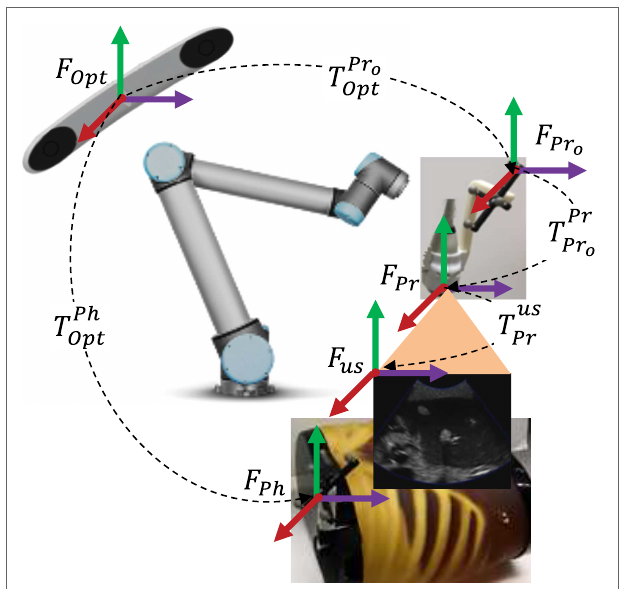
FIGURE 8 | Experimental setup transformation map . During the experiments, the camera frame, F Opt , and the transformations T Pr Pro and T us Pr remained fixed, and the transformations T Pro and T Ph Opt were moving. Opt